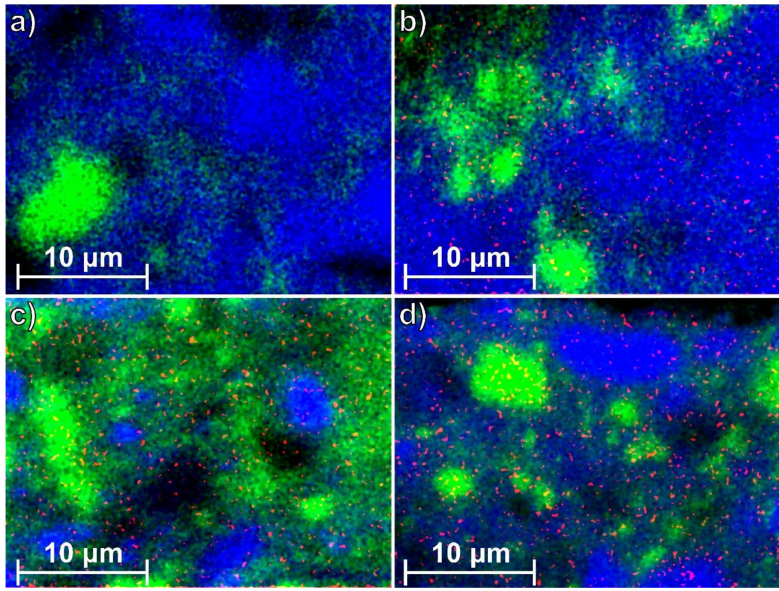
Figure 10. High-resolution EDS mapping on the Herculaneum samples: composite images obtained through RGB convolution of the elaborated elemental maps of lead, iron, and calcium, placed in the R, G, and B channels, respectively. ( a ) BCN_28; ( b ) BCN_W1_03; ( c ) BCN_51; and ( d )